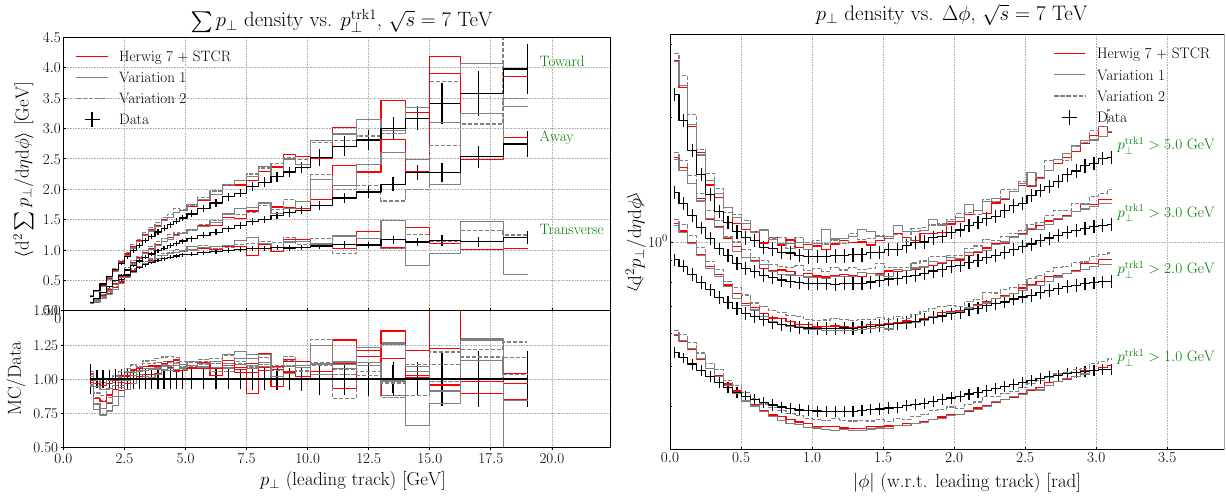
Fig. 12 Predictions for the average sum of particle transverse momenta as a function of the leading track’s transverse momentum, and the average transverse momentum as a function of the azimuthal angle of the leading track